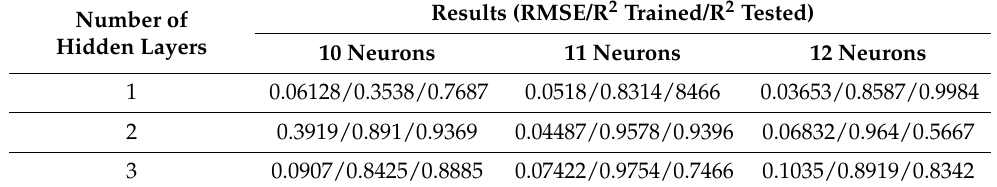
Table 2. ANN training results.